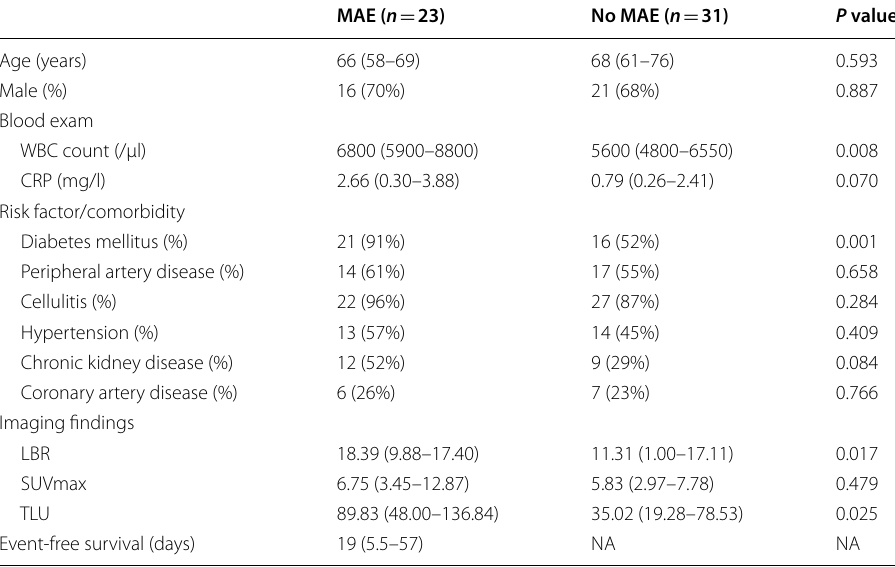
MAE major adverse